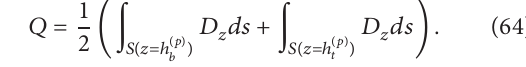
Figure 18: Schematic diagram of the piezoelectric control